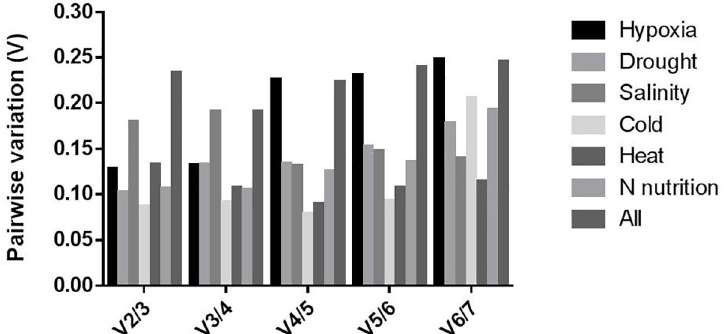
Fig 3. Pairwise variation (V) analysis of the seven candidate housekeeping genes using geNorm software. The pairwise variation (Vn/Vn +1 ) to determine the optimal number of housekeeping genes required for RT-qPCR data normalization. The cutoff value is 0.15.